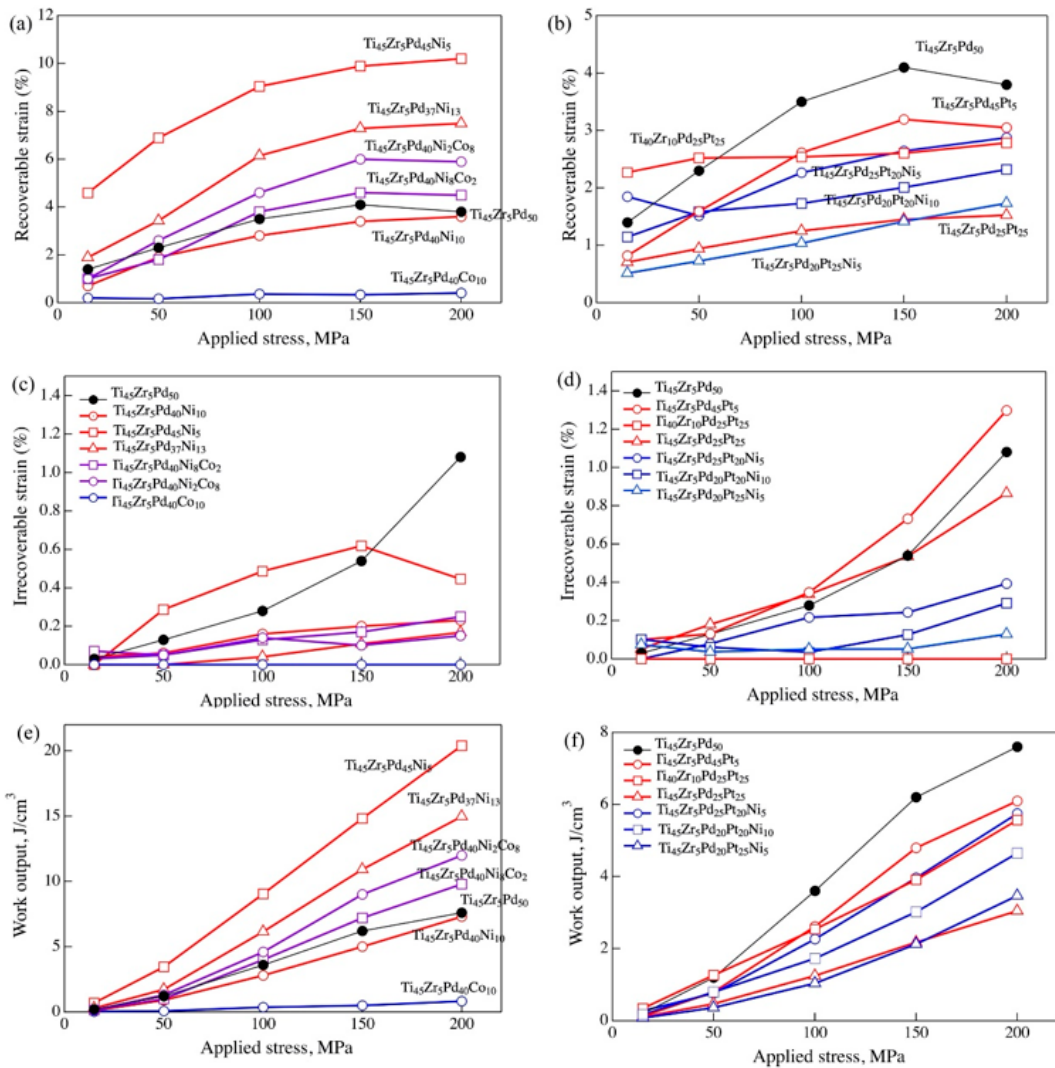
Figure 7. ( a , b ) Recoverable strain, ( c , d ) irrecoverable strain, and ( e , f ) work output obtained from strain–temperature curves of thermal cycle tests of between 15 and 200 MPa for Ti 45 Zr 5 Pd 50 [45] and multi-component alloys. ( a , c , d ) TiZrPdNi alloys [47,48], and ( b , d , f ) TiZrPdPt alloys [45,47,49].